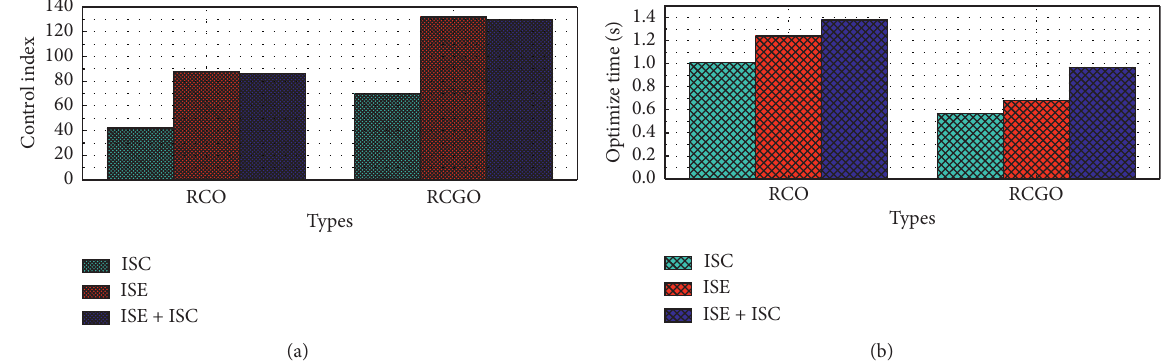
Figure 12: (a) The performance index of the closed-loop control of the process network. (b) The performance index of the real-time calculation of the process